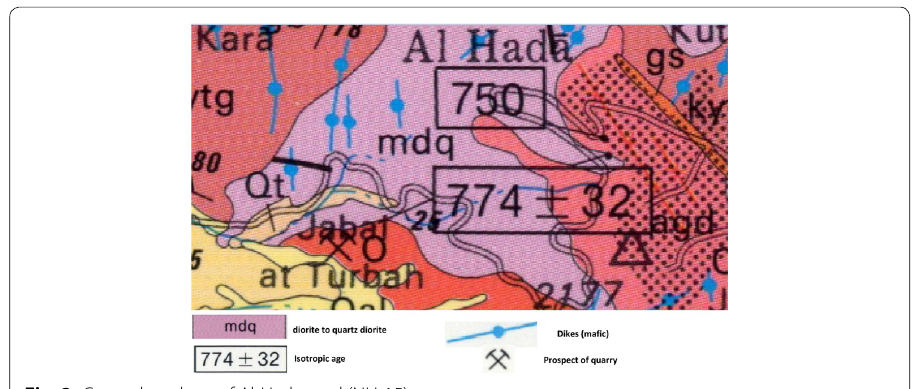
Fig. 2 General geology of Al-Hada road